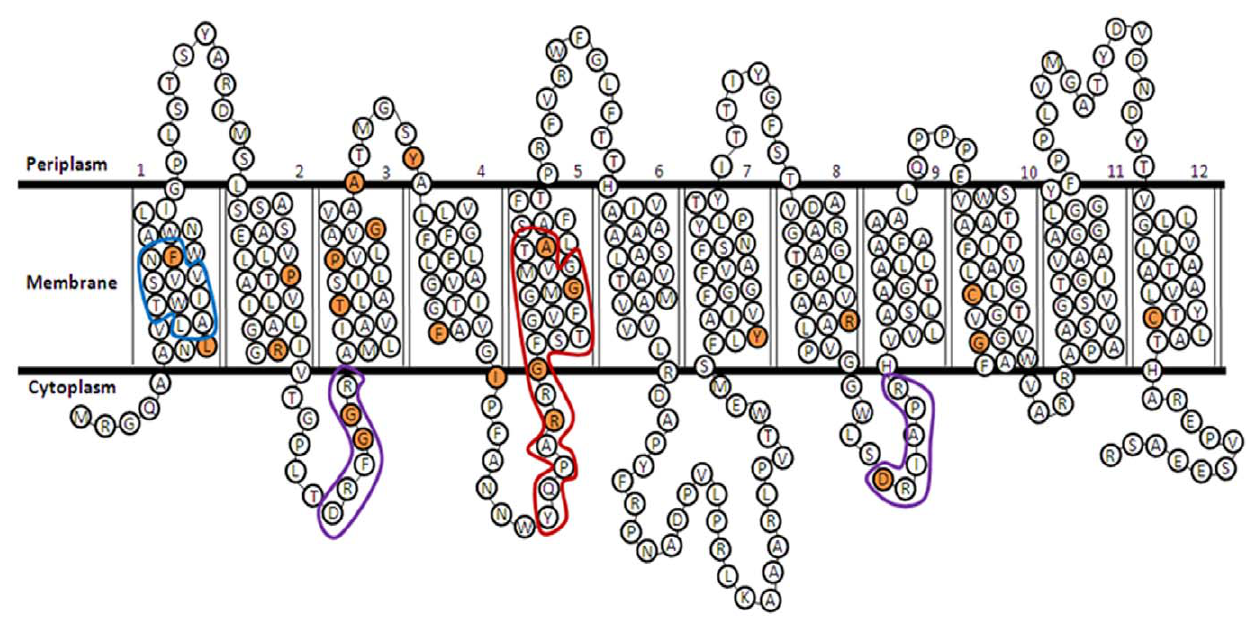
Figure 4. Model of NarK2 secondary structure. The predicted membrane spanning regions are shown. Amino acids that were changed are highlighted in orange. The conserved MFS motif is outlined in purple, the nitrate signature in red, and the eukaryote region in blue.